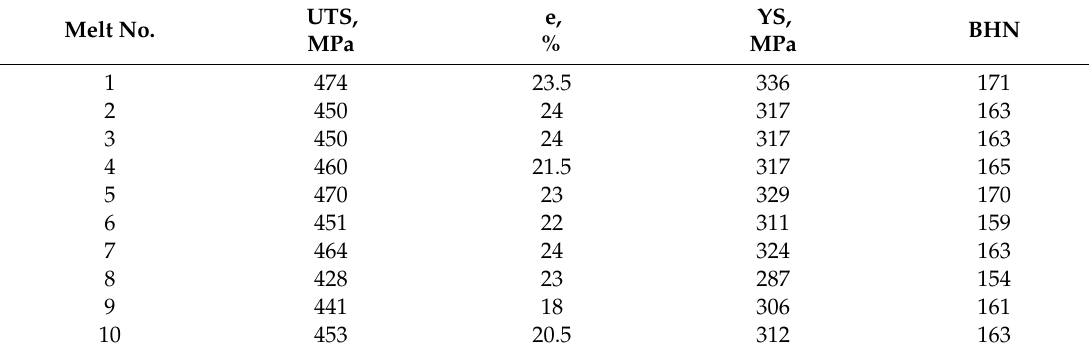
Table 4. Test results of mechanical properties.